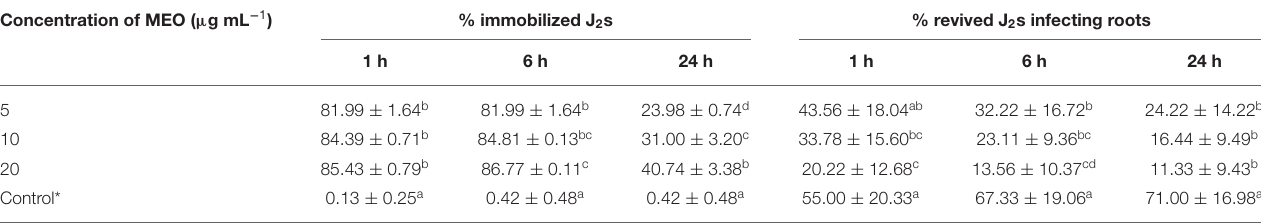
TABLE 2 | Infectivity of M . incognita second stage juveniles (J 2 s) exposed to different concentrations of MEO for different time intervals. Concentration of MEO ( µ g mL − 1 )